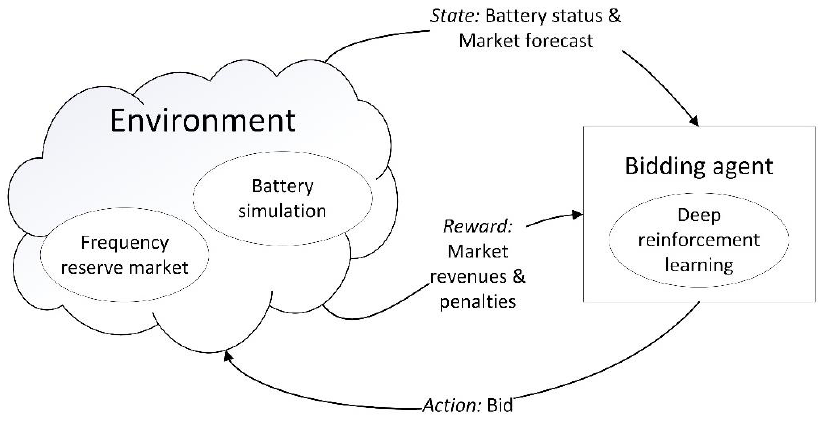
Figure 1. System Figure 1. System overview.